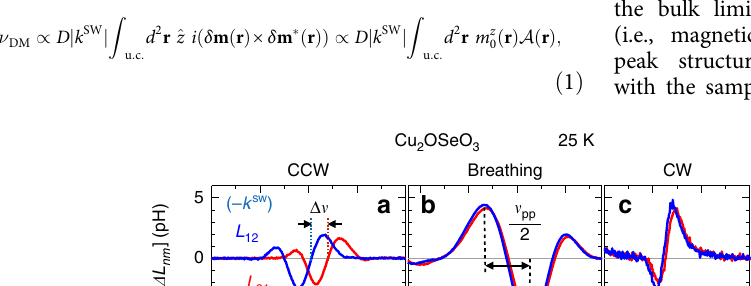
vector + k SW and − k SW . In the right panel, the corresponding cross-sectional images for selected z -planes are also indicated.